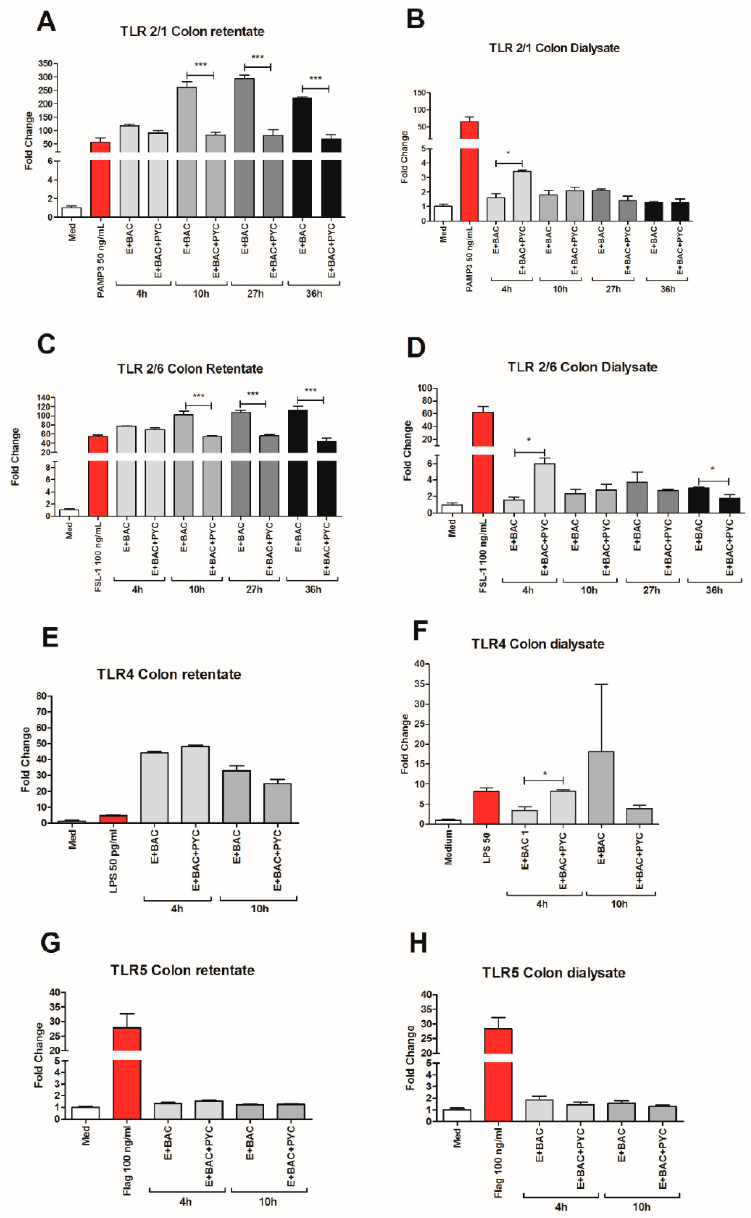
Figure 5. Gastrointestinal metabolism modulates the interaction of PYC with TLRs. PYC was subjected to gastrointestinal metabolism in the presence of human faecal suspension. In the intestinal phase, a semi-permeable dialysis membrane mimics one-way absorption. Both retentate and dialysate samples were taken at specific time points (4h, 10h, 27h, and 36h) and used for stimulation of the HEK 293 cells expressing ( A , B ) TLR1/2, ( C , D ) TLR2/6, ( E , F ) TLR4, and ( G , H ) TLR5, which were also stimulated with their known ligands as positive controls (PAM3, FSL-1, LPS, and flagellin, resp.). After 24 h of incubation, the luciferase activity in HEK 293 cells was measured and expressed as fold change of fluorescence intensity to unstimulated cells cultured in medium as control. PYC samples were metabolized in the presence of E: enzymes; BAC: intestinal bacteria (human faecal suspension). All data are expressed as the mean ± SD of n = 4 technical replicates from two independent experiments. p -values < 0.05 are considered statistically significant, as analyzed with one-way ANOVA with Tukey post hoc comparison test (GraphPad Prism). Significant differences are indicated by asterisks: * p < 0.05; *** p < 0.001.